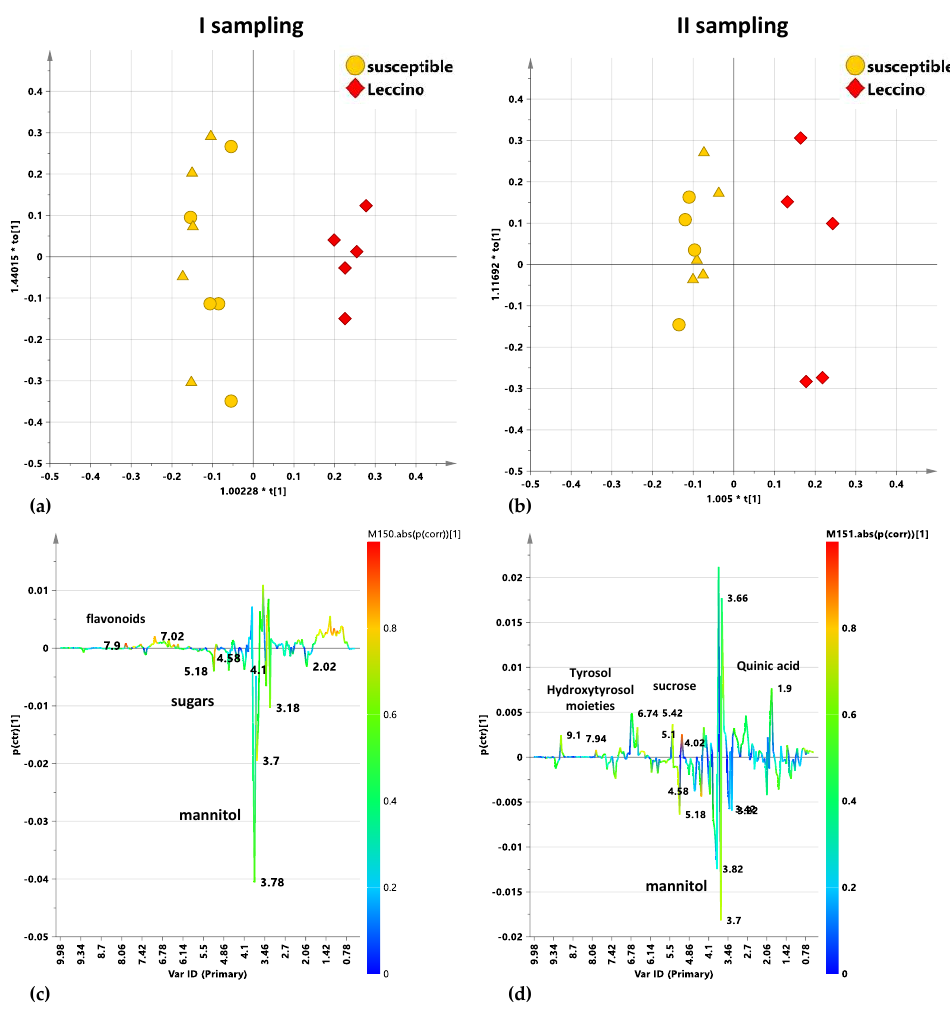
Figure 7. OPLS-DA t[1]/t[2] scores plot for Leccino and susceptible cultivar considering, infected control untreated leaf samples considering the first ( a ) and the second sampling ( b ). Different symbol style for Cellina di Nardò (circles) and Ogliarola salentina (triangles) susceptible cultivars are reported. S-line plots for the first ( c ) and the second sampling ( d ) related models visualizes the p(ctr)[1] loading colored according to the absolute value of the correlation loading, p(corr)[1]. Infected control trees.